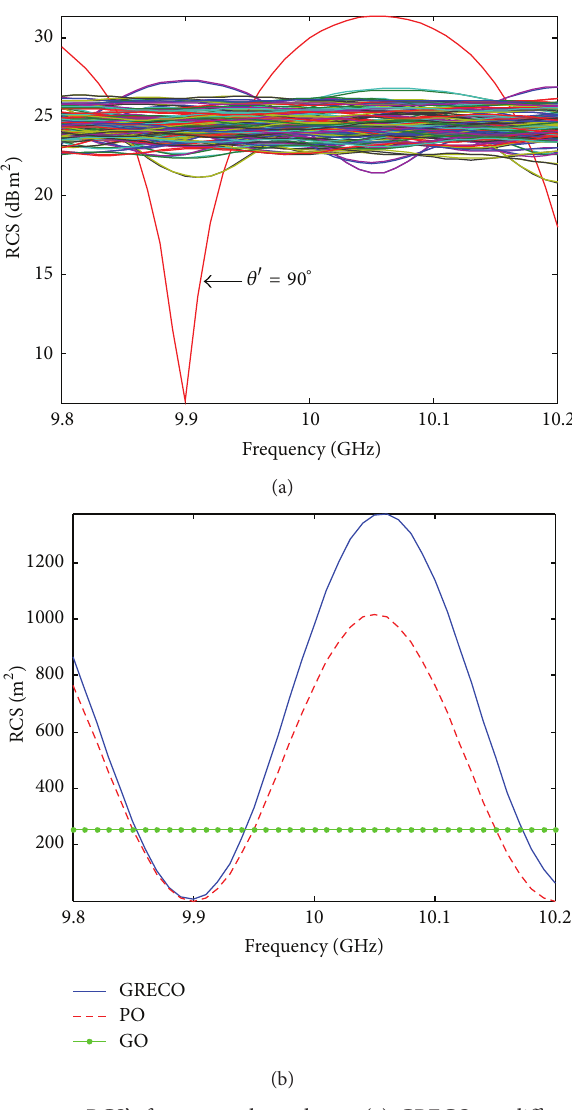
Figure 5: RCS’s frequency dependency. (a) GRECO, at different aspects; (b) GRECO, PO, and GO, 𝜃 󸀠 = 90 ∘